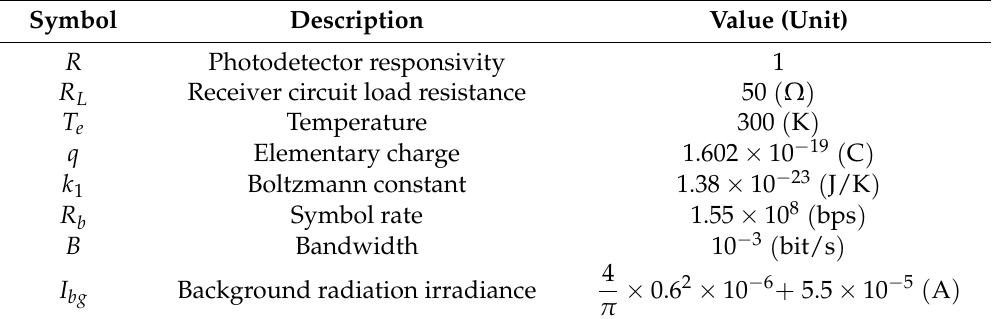
Table 1. Parameters used in the